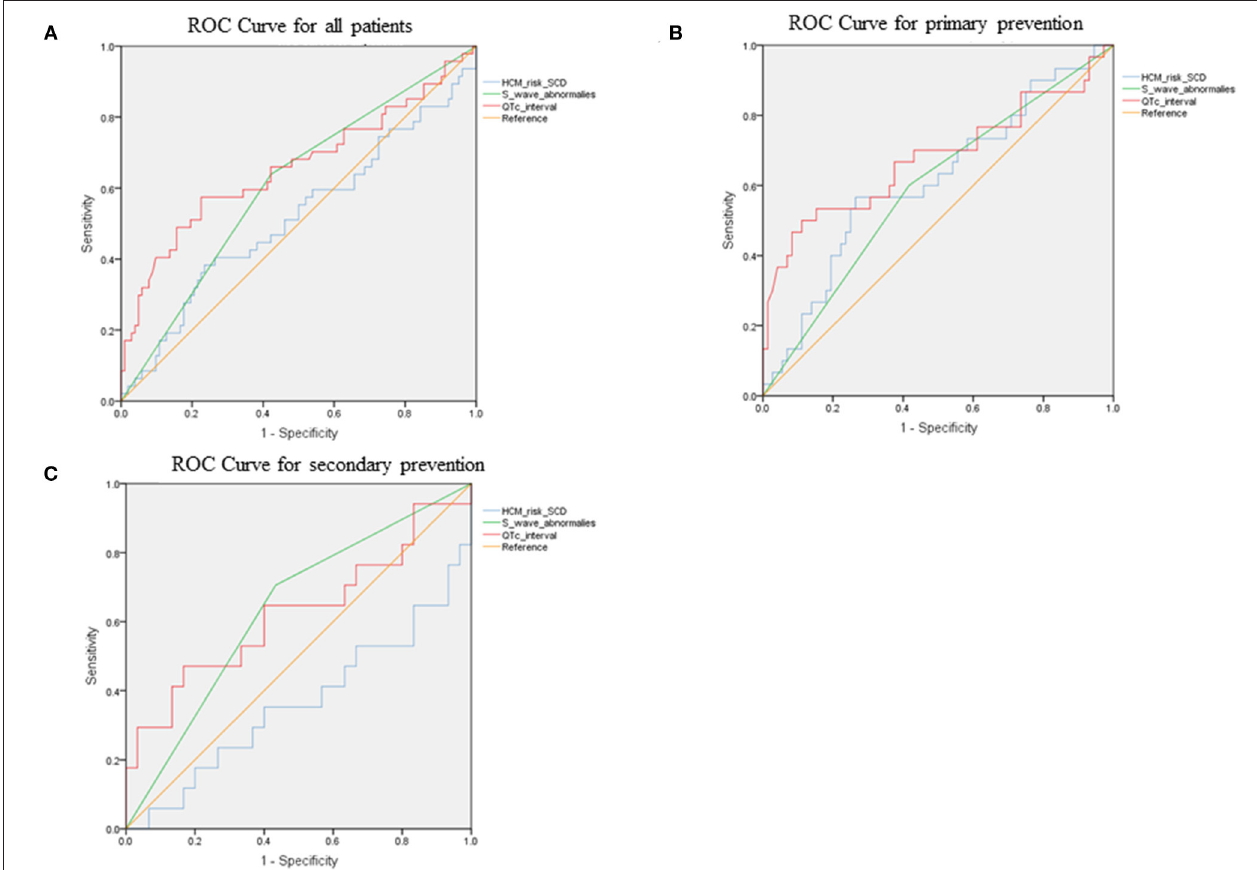
FIGURE 2 | The ROC curves for predicting appropriate ICD therapies by HCM-risk-SCD model, QTc interval, and V4-S wave. (A) for all patients, (B) for primary prevention, and (C) for secondary prevention. ROC, receiver operating curve; ICD, implantable cardioverter-defibrillator; HCM, hypertrophic cardiomyopathy; SCD, sudden cardiac